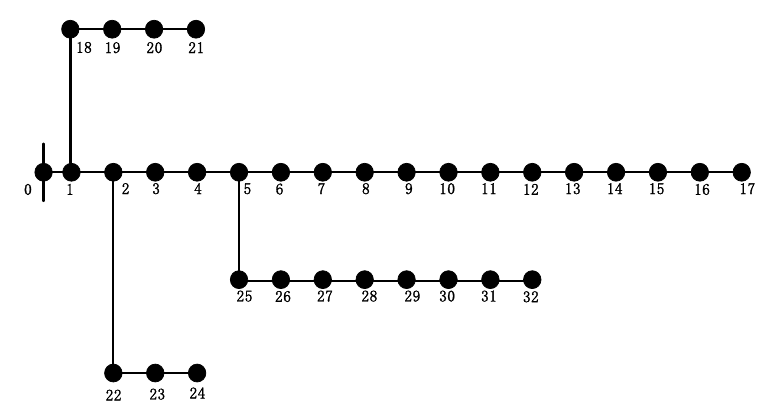
Figure 1. Grid structure of the IEEE-33 bus standard system.